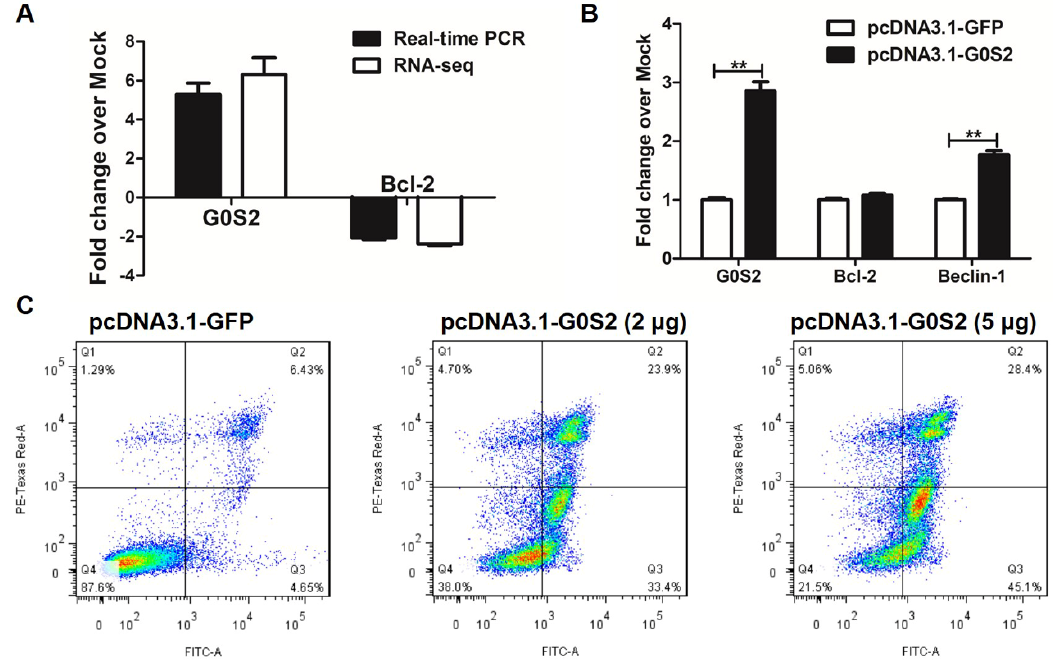
Figure 6. Metformin modulates apoptosis via G0S2 in macrophages. ( A ) Validation of RNA-Seq data for G0S2 and Bcl-2 in metformin-treated HD11 cells by real-time PCR. ( B ) RT-qPCR analysis of G0S2, Bcl-2 and Beclin-1 gene expression in macrophages transfected with 2-µg G0S2 plasmid. ( C ) Flow cytometry results showed that over-expression of G0S2 induced apoptosis in HD11 cells. The X axis represents Annexin V-FITC and the Y axis represents PI. Q1 represents necrotic cells, Q2 represents late apoptotic cells, Q3 represents early apoptotic cells and Q4 represents normal cells. ** represents p < 0.01.